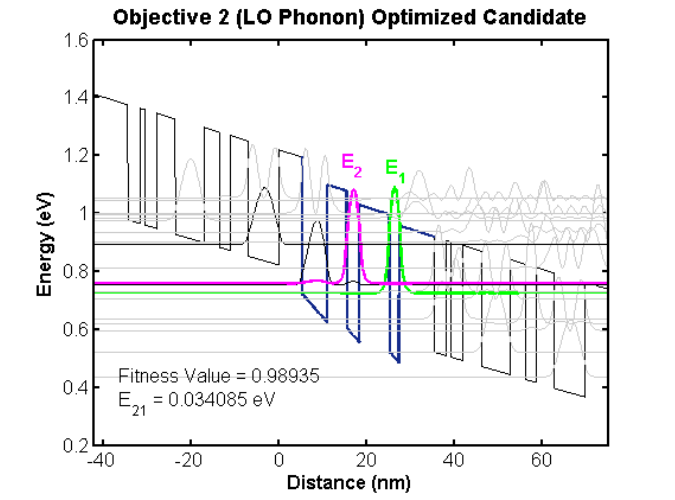
Figure 9. Al x Ga 1 − x As/In y Ga 1 − y As QC laser candidate simulated on GaAs (111) with top objective (2) fitness rank given a training initial population. Relevant wave functions, E 2 and E 1 are in bold and